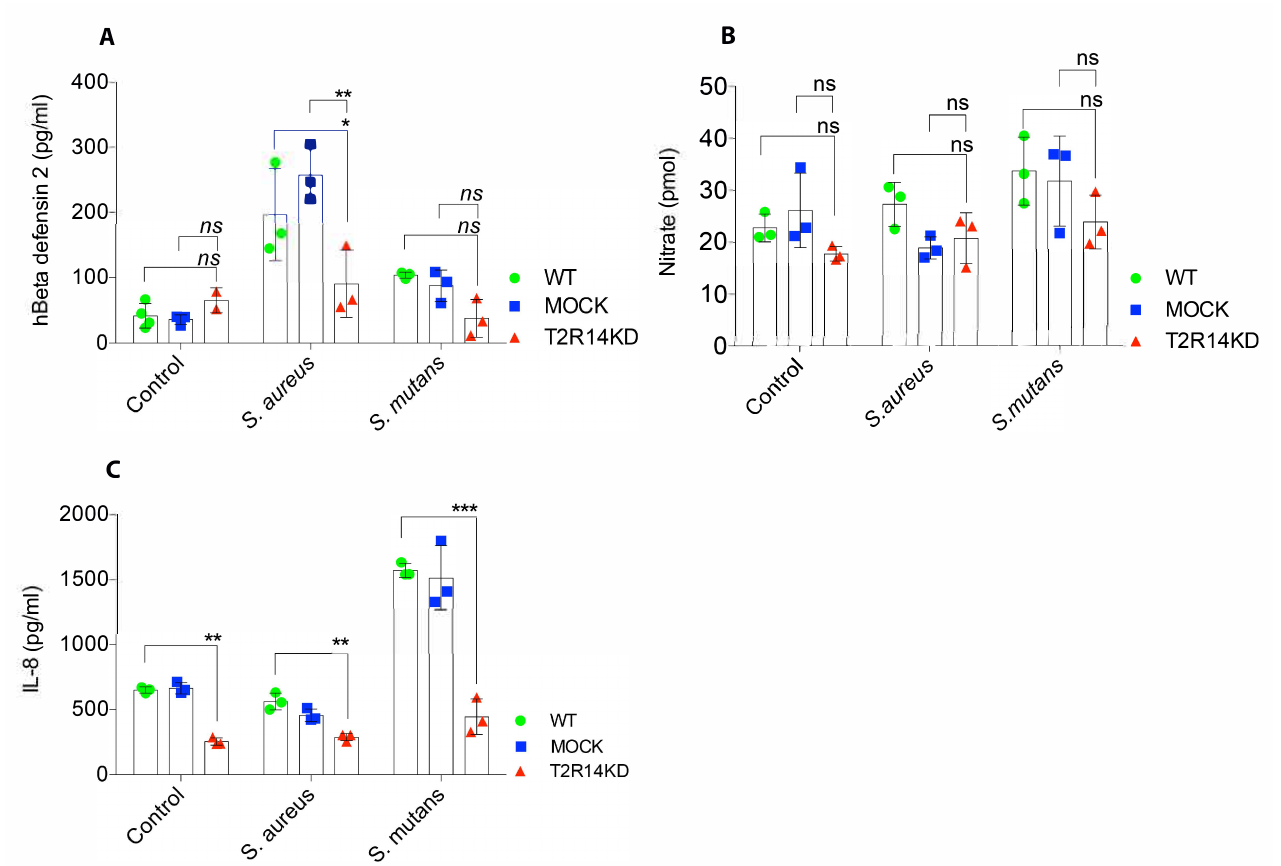
Figure 3. Characterizing the secretion of antimicrobial peptide hBD-2, nitrite/nitrate and IL-8/CXCL8 by ELISA. The OKF6 WT, MOCK and T2R14 KD cells were infected with S. aureus (50 MOI) and S. mutans (100 MOI) for 18 h. After infection, the supernatants were collected and filtered by using 0.25 µ m nylon filter to remove cellular debris and bacteria. The supernatant was then used to determine secreted innate immune markers, such as ( A ) hBD-2, ( B ) nitrite/nitrate and ( C ) IL-8/CXCL8 as mentioned in methods. The representative grouped bar graphs were generated by using GraphPad Prism 7.0. The data represented in the graphs are SEM of ≥ 3 independent experiments. Two-way ANOVA analysis, using Tukey’s multiple comparison analysis, was performed, and the observed p -values are * p = 0.01, ** p = 0.004 and *** p = 0.002, ns = not